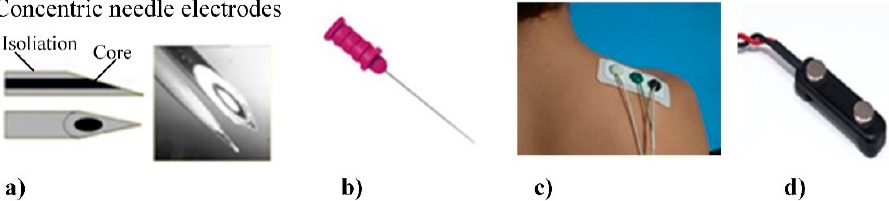
Figure 12. Example of EMG electrodes [148]: ( a ) needle electrode; ( b ) fine wire electrode; ( c ) gelled electrodes; ( d ) dry electrodes.